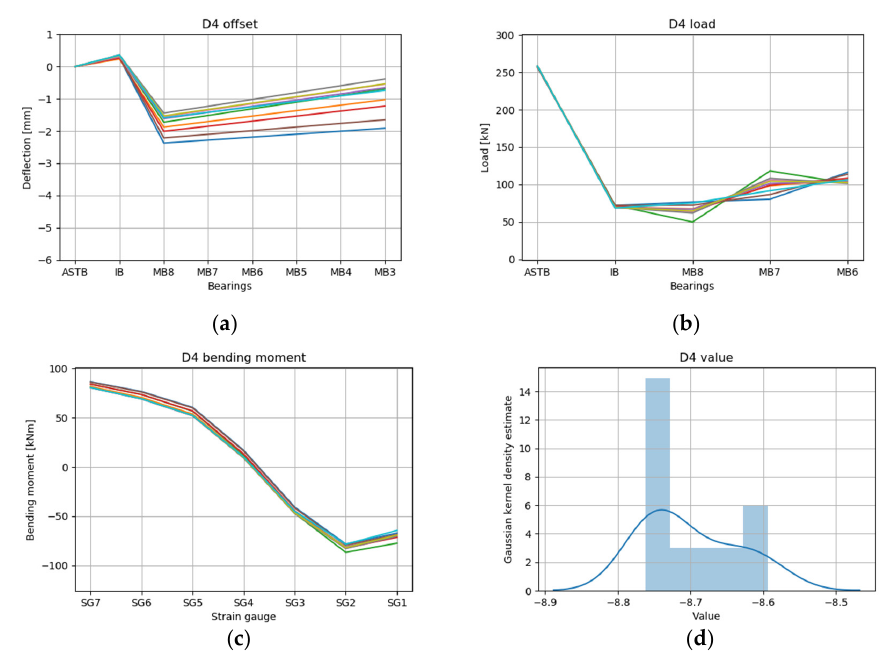
Figure 20. RL results for draft condition D4 top 10 cases: ( a ) offset, ( b ) load, ( c ) bending moment, and ( d ) value.